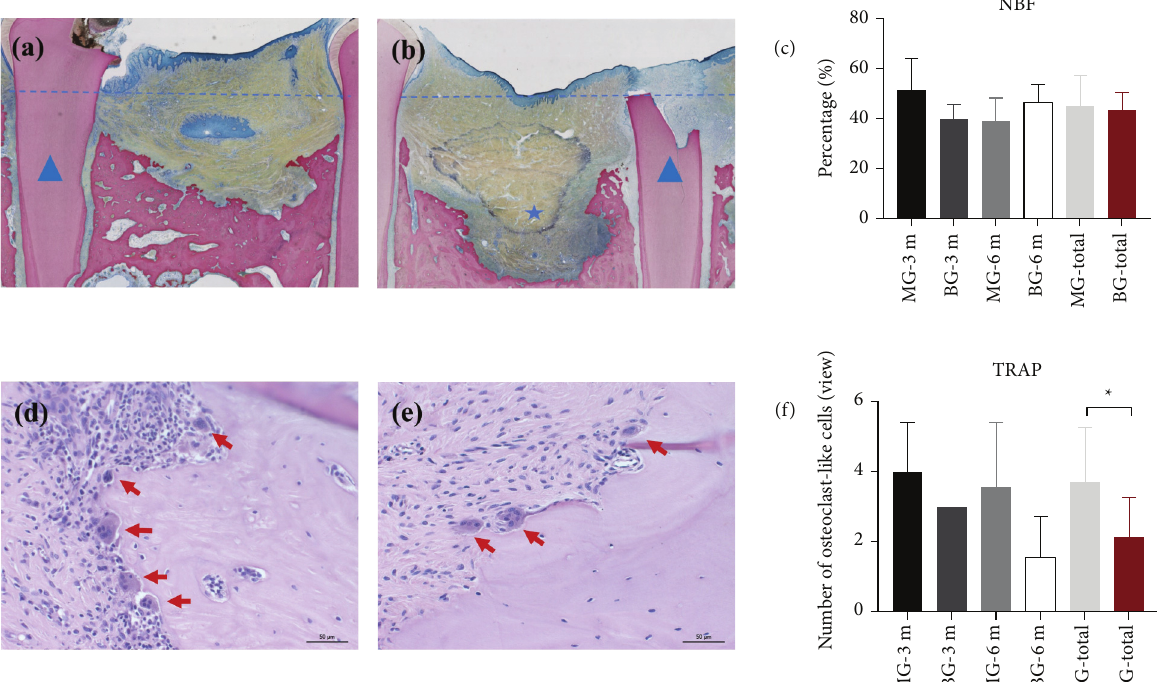
Figure 6: Quantitative histology of bone formation in the bone defect area. (a, b) Van Gieson’s-stained sections of bilateral P2 sites in one beagle dog ((a) group MG-3 m, (b) group BG-3m). New bone repair can be clearly observed in the group MG, whereas the defect area in the group BG is filled mostly with fibrous connective tissue (blue star). The blue triangle denotes the remaining mesial root. The blue dashed line denotes the level of the enamel-cementum junction. (c) Percent new bone formation (NBF) in different groups. (d, e) TRAP-stained sections in different groups ((d) group MG-3 m, (e) group BG-3 m). TRAP (+) cells are shown by a red arrow. (f) Average number of TRAP (+) cells in different groups under field of views at 200x magnification. ∗ P < 0 . 05, ∗ ∗ P < 0 . 01.